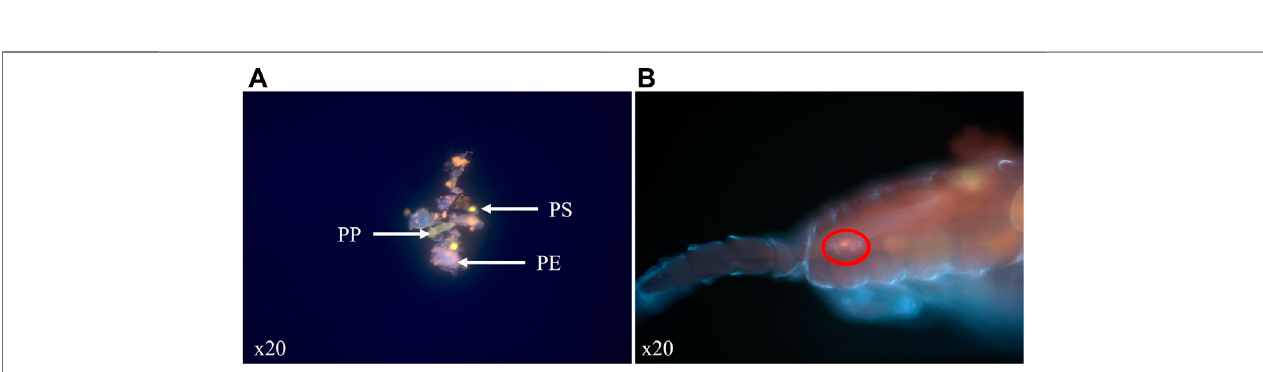
FIGURE2| Sampleof insitu MPsmixturestainedwithNileRedandobservedwithepi fl uorescencemicroscope(crimelight:455 – 494 nm) (A) . (B) Observationof in situ MPs ingested and visible (red circle) as a compact orange orb in the digestive tract of an adult copepod of E. af fi nis .